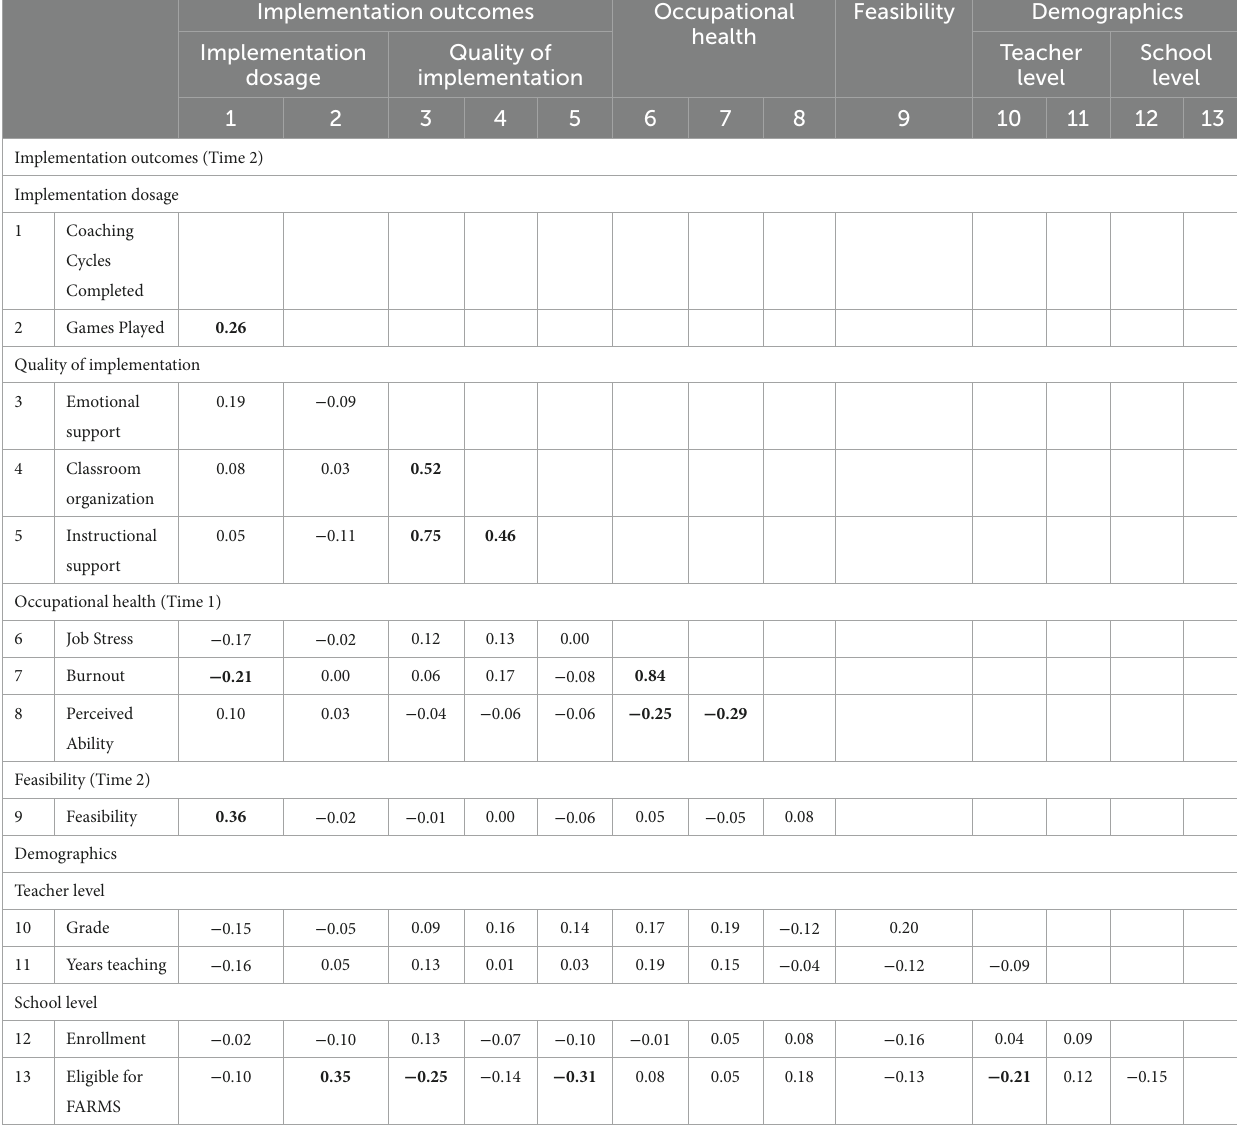
TABLE 2 Bivariate correlations among study